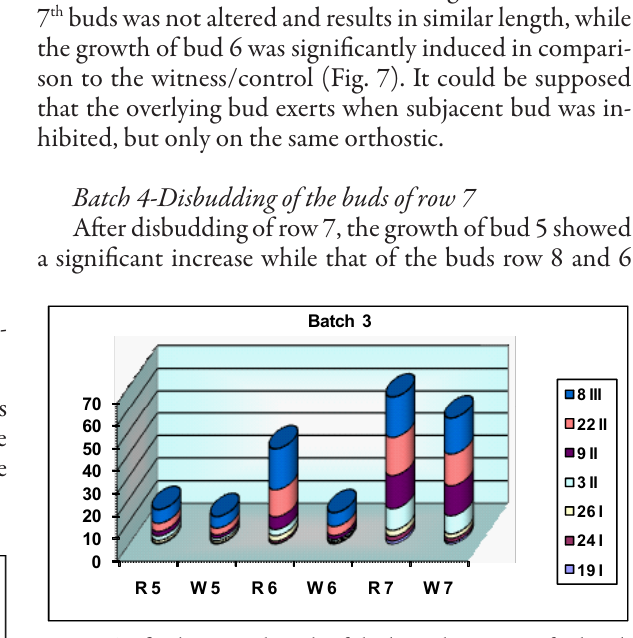
Fig. 7. The final average length of the branches, in cm, for